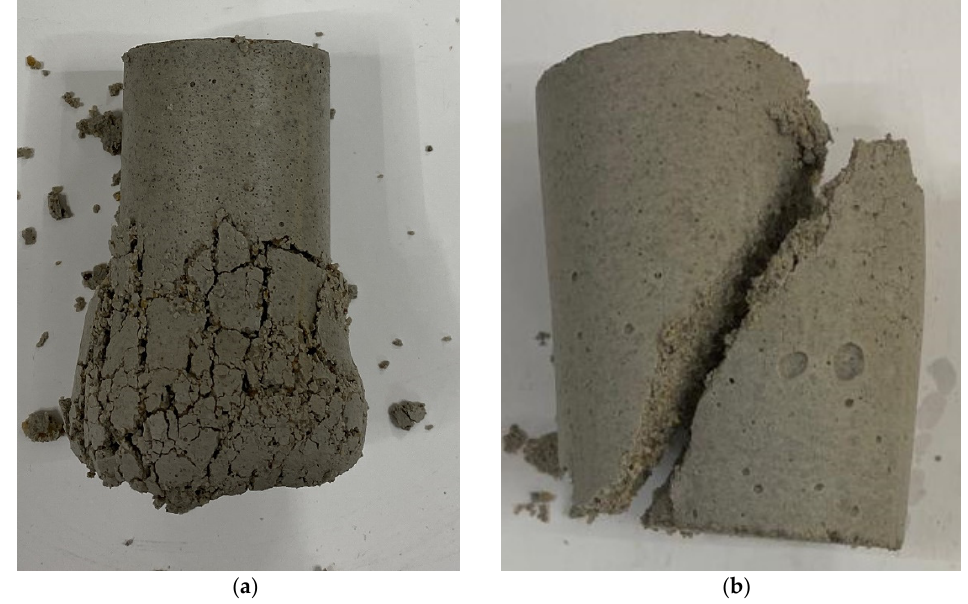
Figure 7. Failure patterns of plastic concrete samples. ( a ) “weak concrete”—compressive failure. ( b ) “strong soil”—shearing failure.